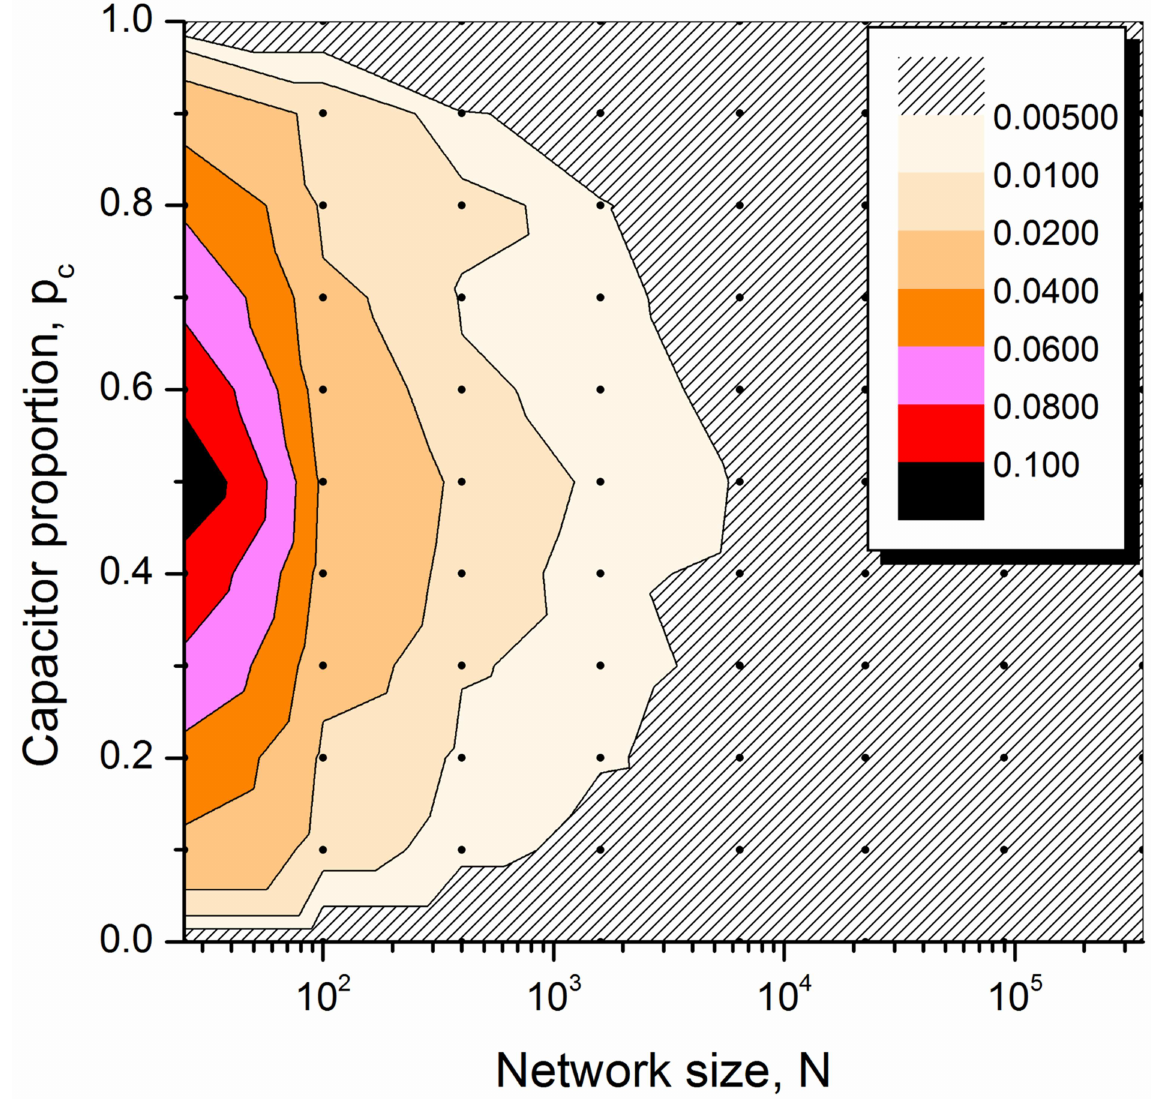
Fig 3. Mapping of the standard deviation of normalised characteristic admittance values. For varying capacitorproportions from 0.1 to 1.0, different-sized squarenetworks (from 5 × 5 to 600 × 600) were considered. For a given network size and capacitor proportion, ten RC networks were generatedand used in the simulations to obtain the averaged normalised characteristic admittance, representedby the black dot. The STD of these points are used for mappingwith the colour indicating the STD values, as detailed in the